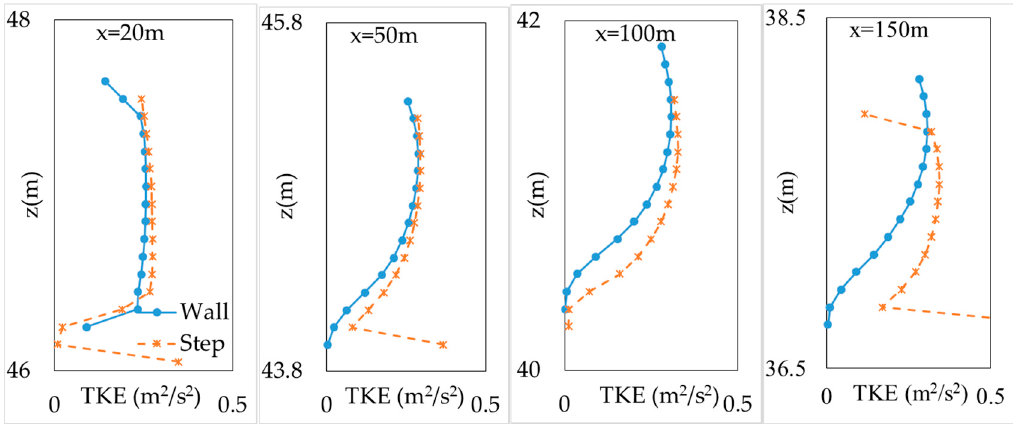
Figure 20. Turbulence kinetic energy (TKE) estimated with and without the air entrainment model in cases with wall (W) and step (S) abutments when Z up = 55.86 m.